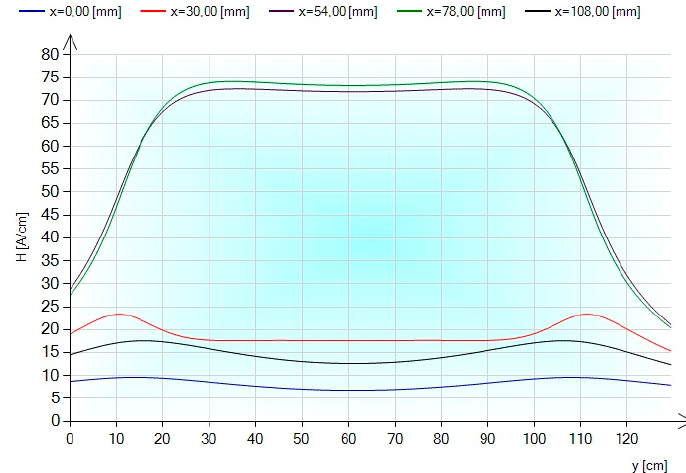
Figure 14. The distribution of magnetic field intensity of an unshielded busbar system for y = var and different values of x = const in the case of current symmetry. Energies 2019 , 12 , 1419